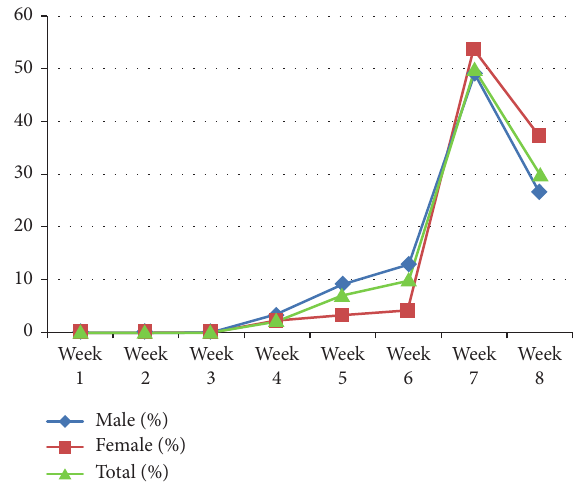
Figure 1: Trends of COVID-19 infection in the northeastern re- gion of Ethiopia from July 01 to August 31,